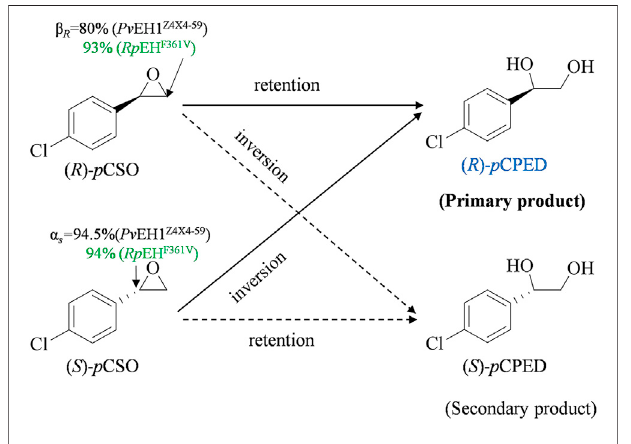
FIGURE 1 | The enantioconvergent hydrolysis of rac-p CSO into ( R )- p CPED catalyzed by E. coli/pveh 1 Z4X4-59 and E. coli/rpeh F361V , respectively. E.coli/pveh 1 Z4X4-59 attacksattheC β of( R )- p CSOwith β R of80% mainly affording ( R )- p CPED and at the C α of ( S )- p CSO with α S of 94.5% also mainly affording ( R )- p CPED. E. coli/pveh 1 Z4X4-59 attacks at the C β of ( R )- p CSO with β R of 93% mainly affording ( R )- p CPED and at the C α of ( S )- p CSO with α S of 94% also mainly affording ( R )- p CPED.